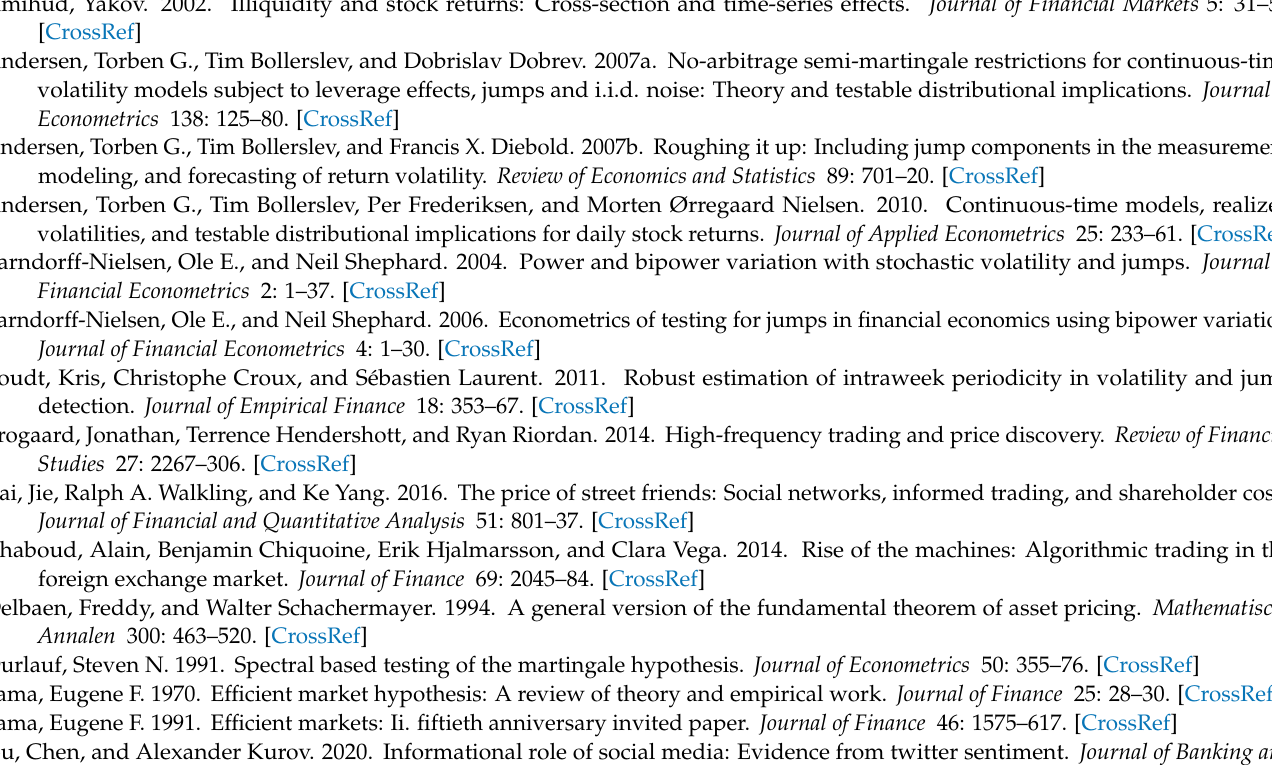
Considerations of the full limit order book include, for example, translating the bid-ask spread price impact regression Huang and Stoll (1997) to the semi-martingale setting. This would for allow the analysis of the price impact of small orders, complementing the analysis of large orders presented in this